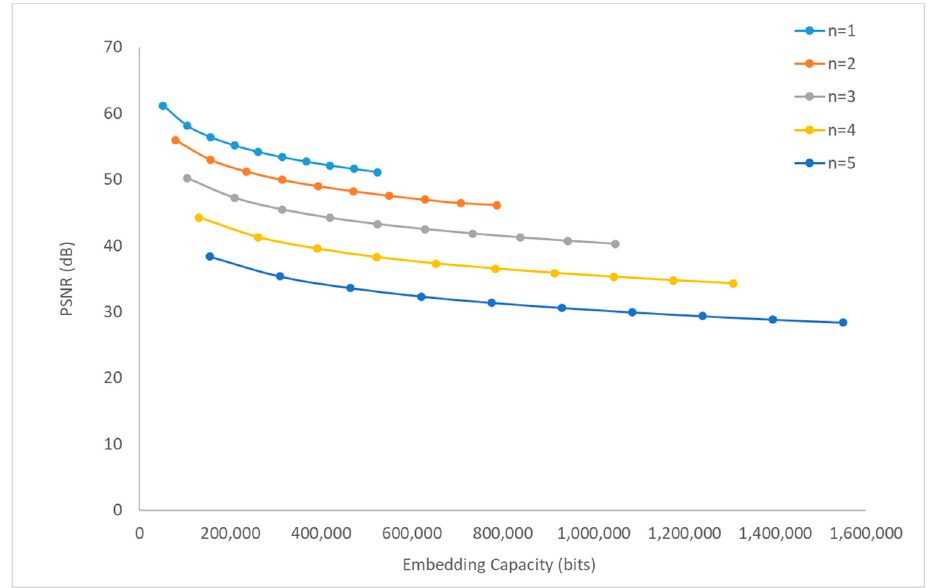
Figure 7. Comparisons of embedding capacity and PSNR values for n = 1 to 5 in grayscale images. Table 8. Comparison of average P, EC and PSNR values for n = 1 to 5 in all colored images used in experimental